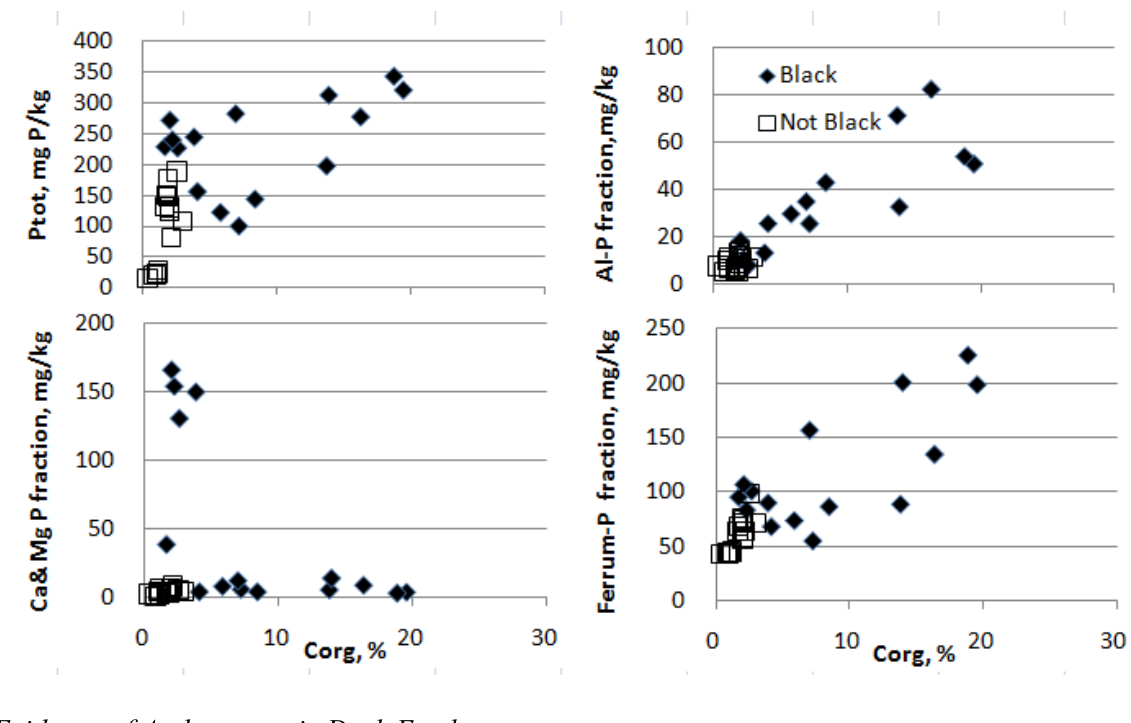
Figure 2. Relation between organic carbon (C other P fractions (Fe-P, Al-P,